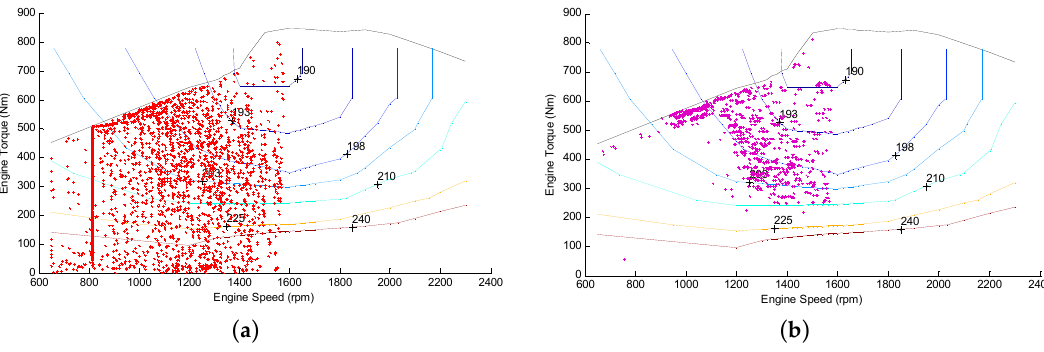
Figure 13. ( a ) Engine operation points of Charge Depleting-Charge Sustaining (CD-CS) strategy; and ( b ) engine operation points of mixed logic dynamical-model predictive control (MLD-MPC) Strategy. Table 7. Fuel consumption under two control strategies. NEDC: New European Drive Cycle; OCC: Orange County Bus Cycle.